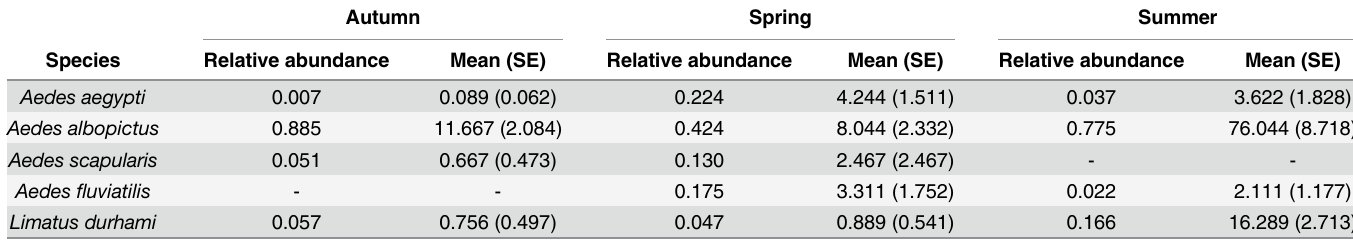
Table 3. Relative abundance of the pupal productivity for each mosquito species and mean (standard error) pupae produced per vase at the end of the 30 days period of colonization in the Autumn, Spring and